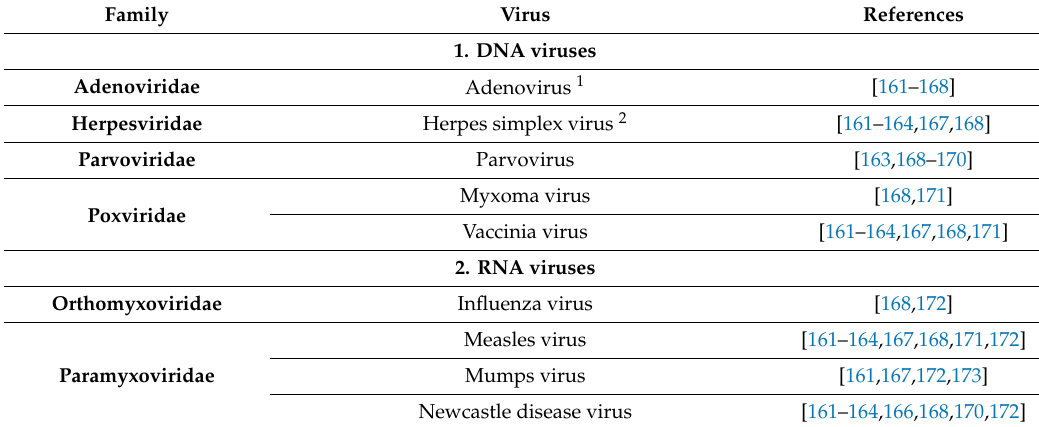
Table 3. Oncolytic